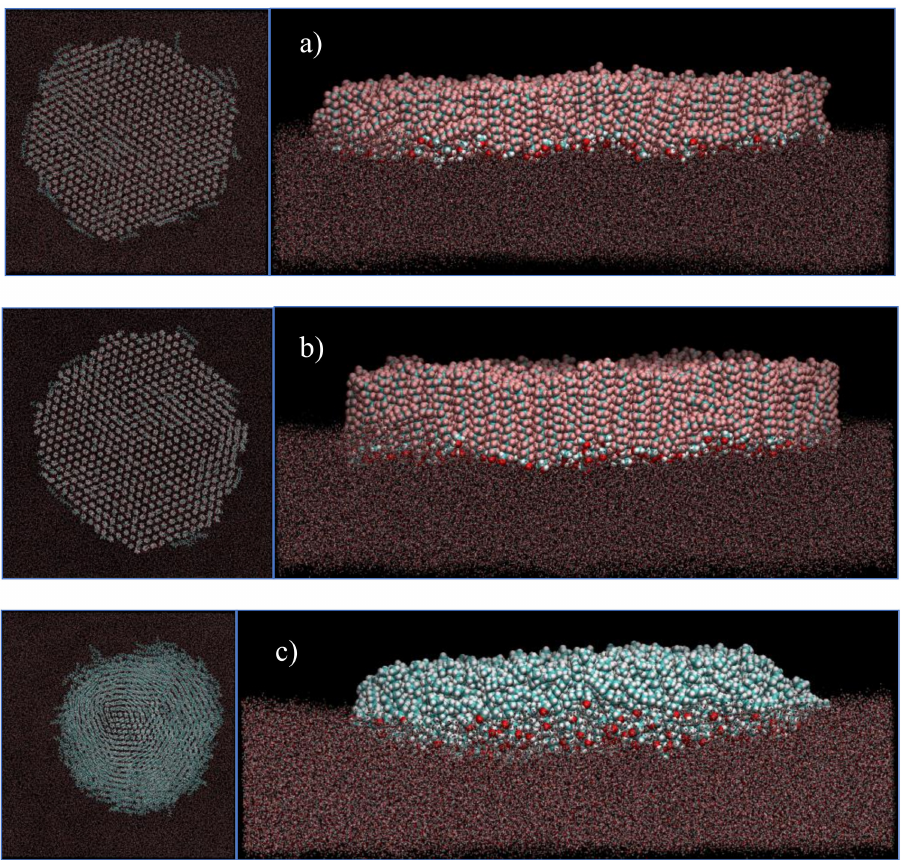
Figure 6. Representative snapshots, top-view (left) and side-view (right), of the equilibrated Langmuir films at the surface of water at 0.6 nm 2 / molecule of ( a ) F14OH, ( b ) F18OH and ( c ) H18OH. All films contain 550 alcohol molecules. Water molecules are represented by dots for